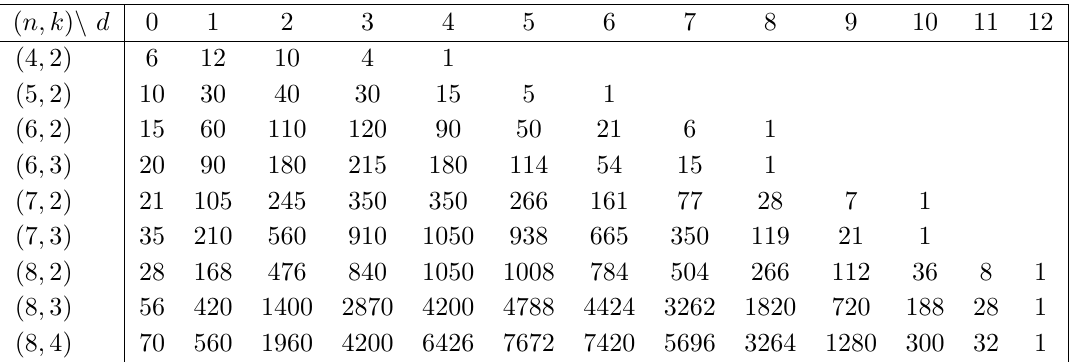
Table 1 . The number of boundaries of M n;k of a given dimension.